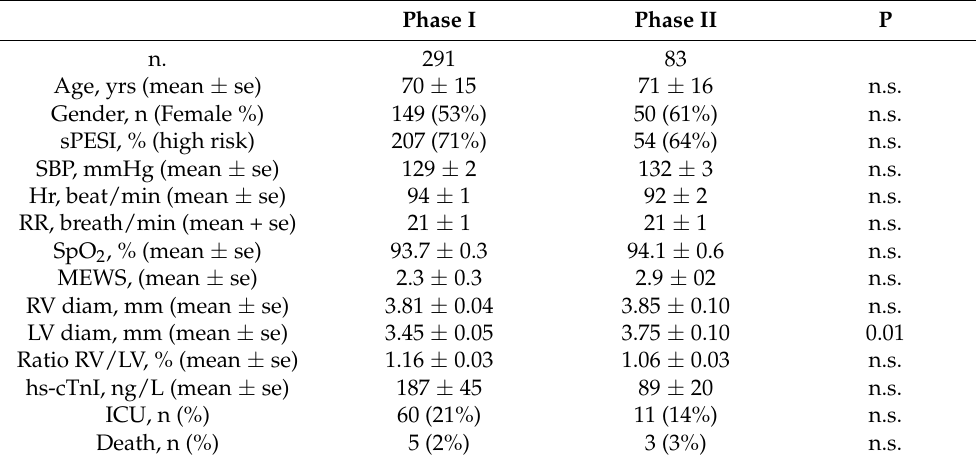
Table 1. Patients’